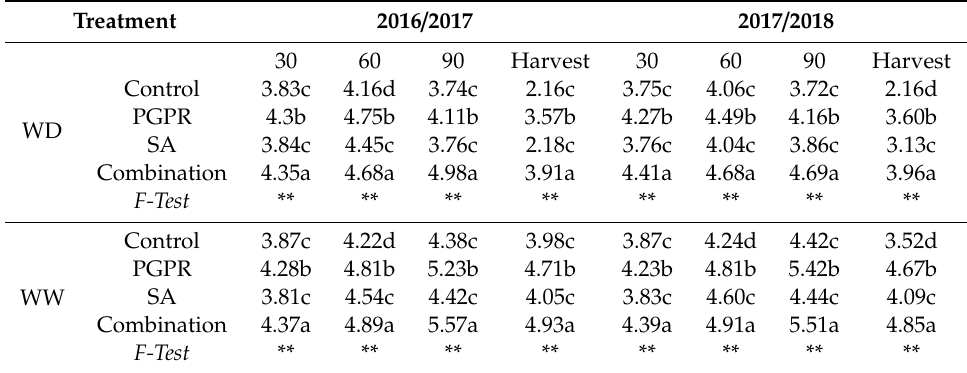
Table 5. Total count (Log CFU mL − 1 ) of N 2 -fixing bacteria as a ff ected by inoculation with plant growth promoting rhizobacteria (PGPR) and foliar spray with salicylic acid (SA) and their combination under water deficit conditions during 2016 / 2017 and 2017 / 2018